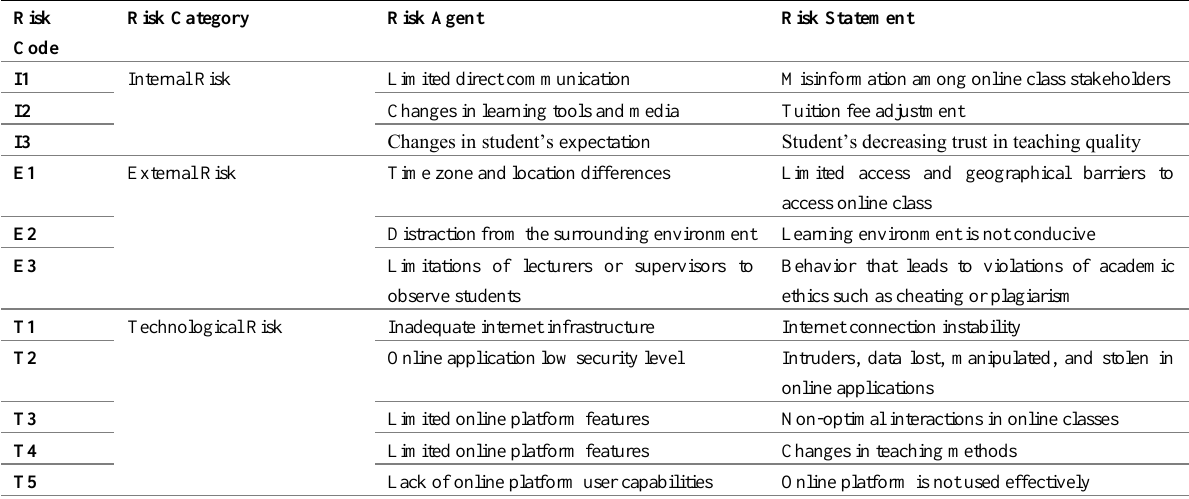
Table 1: Risk Agent and Risk Statement from Triangulation